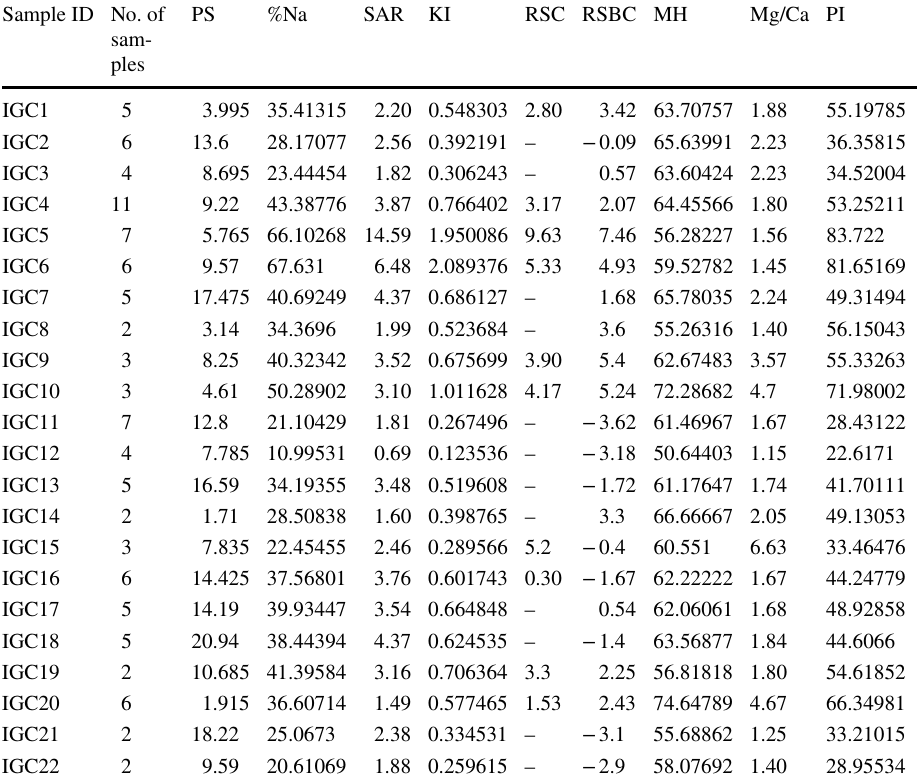
parameters (mean values in meq/l) of groundwater